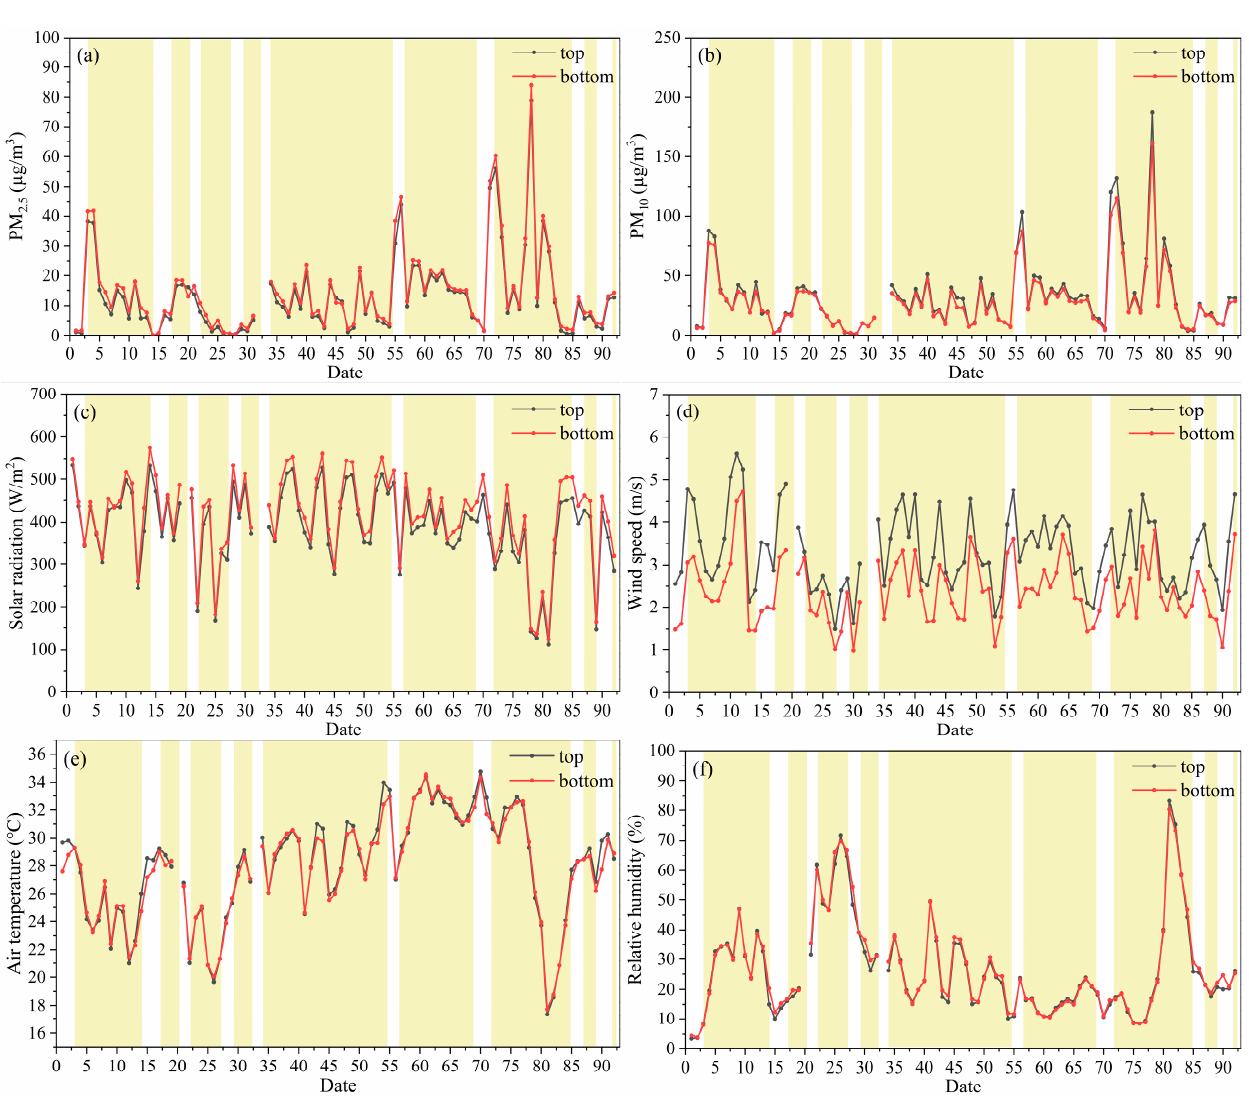
Figure 3. Temporal variations in the daily average PM 2.5 concentration ( a ), PM 10 concentration ( b ), SR ( c ), WS ( d ), T ( e ), and RH ( f ) at the top and bottom of the dunes from June to August 2019 at TZ. The yellow areas represent the dust days. Table 1. Monthly average PM 2.5 concentration, PM 10 concentration, SR, WS, T, and RH at the top and bottom of the dunes from June to August 2019 at TZ in the